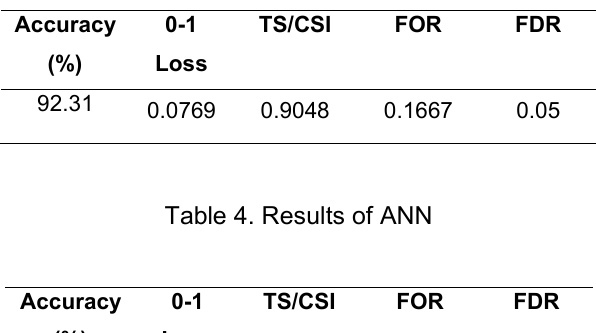
Table 3. Results of SVM with Gaussian kernel